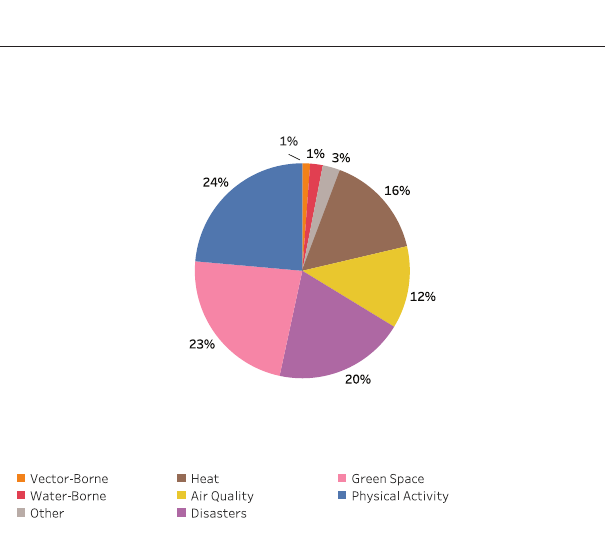
FIGURE 4 | Percent of all exposure references by exposure sub-category from our review of 33 CAPs from all 27 included